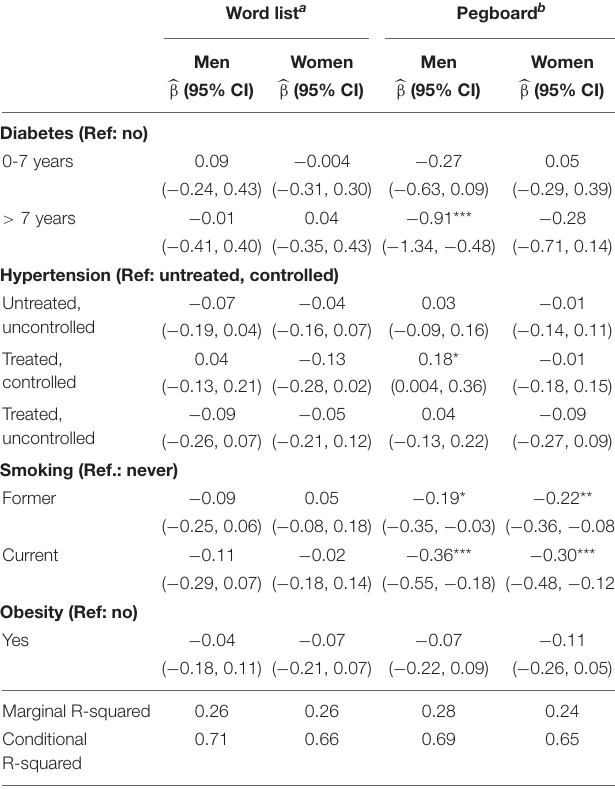
TABLE 3A | Sex-specific effects of potential risk factors on standardized test results from the word list and Purdue pegboard test. Word list